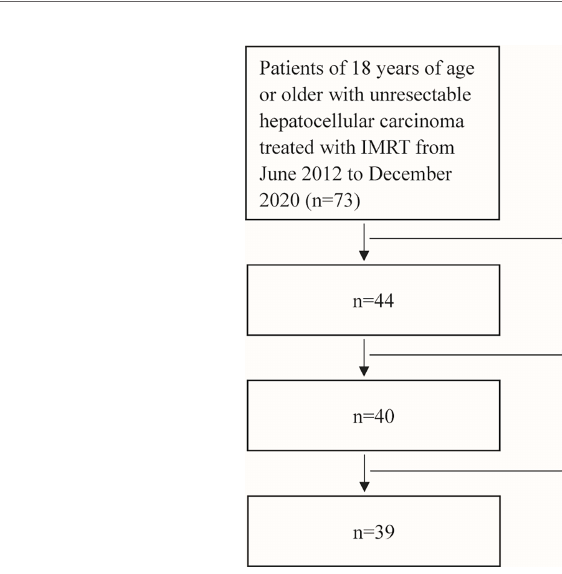
liver MRI protocol included non-fat suppressed coronal single- shot fast/turbo spin-echo T2WI (SS-FSE/HASTE), axial fat suppressed fast/turbo spin echo (FSE/TSE) T2WI, T1WI in-